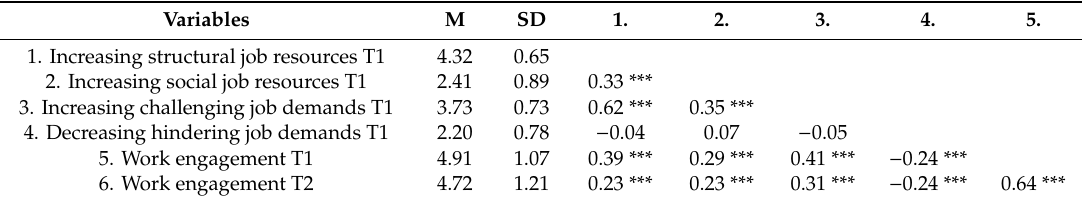
Table 1. Means, standard deviations, and Pearson correlations of study variables among participants facing changes in their work content ( n = 479).